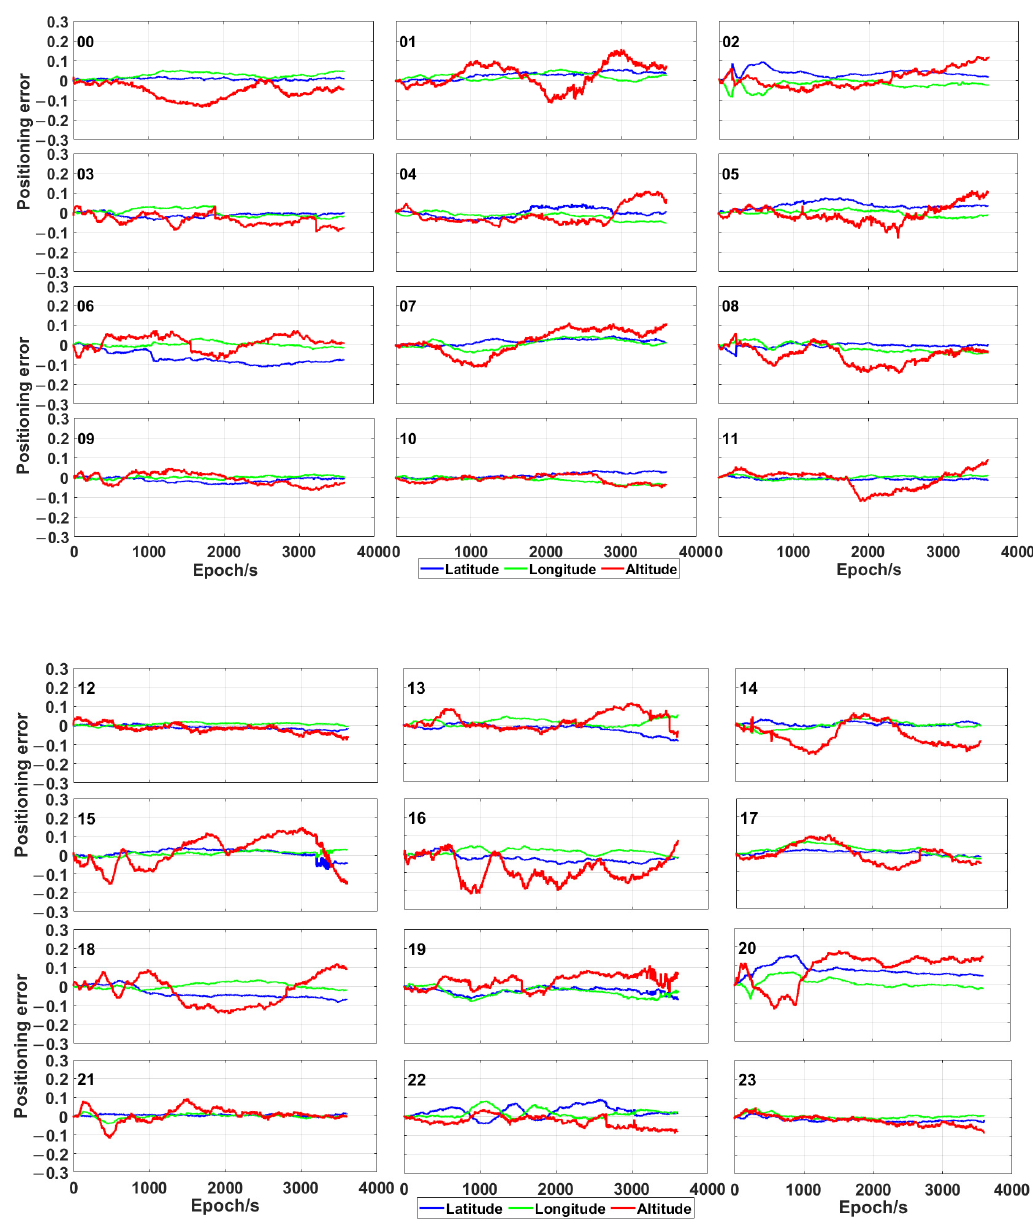
Figure 5. Positioning error (expressed in metres) obtained by means of the proposed time-relative positioning method by using only GPS at different hours.